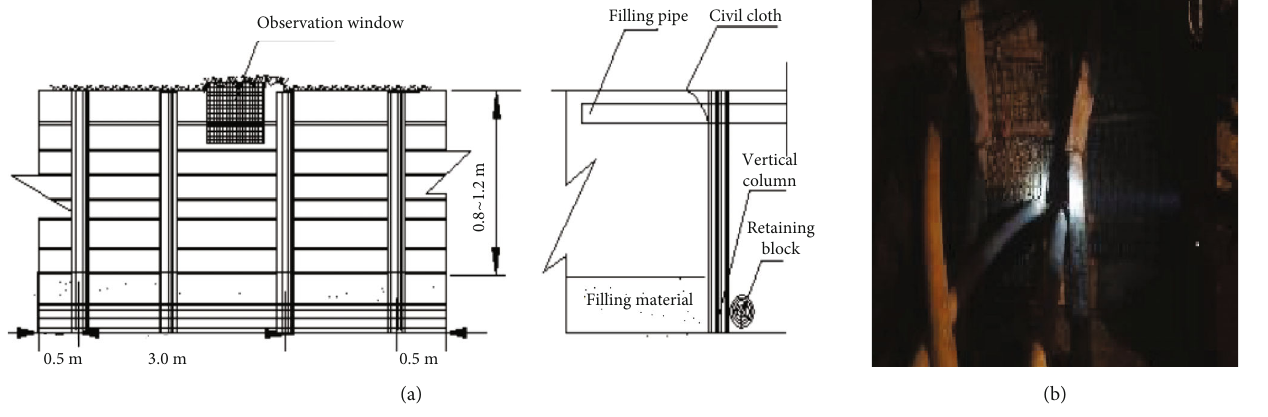
Figure 8: (a) The structure of retaining wall and (b) the hanging recycled fi lling retaining